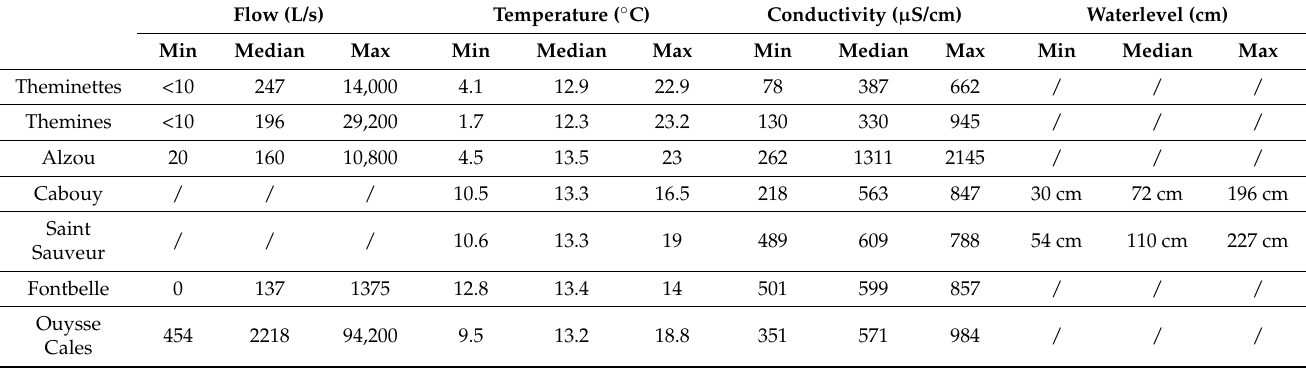
Table 1. Summary of statistics on the flow/water level, temperature, and conductivity at each monitored station.